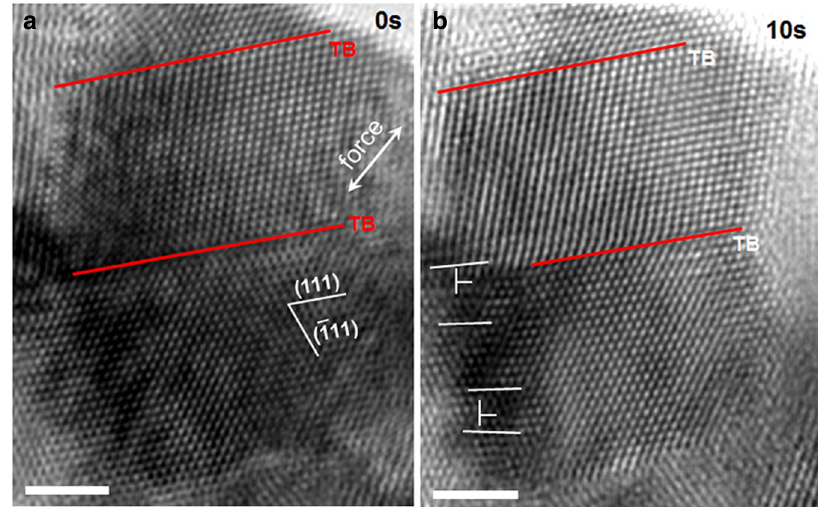
Fig. 1 In situ observation of full dislocation nucleation in a grain that contains both relatively thick and thin twins/matrixes. a The relatively thick twins/ matrixes are free of defects. b Two full dislocations (marked as T) glide on the {111} planes intersecting with the TBs. The scale bars are for 1